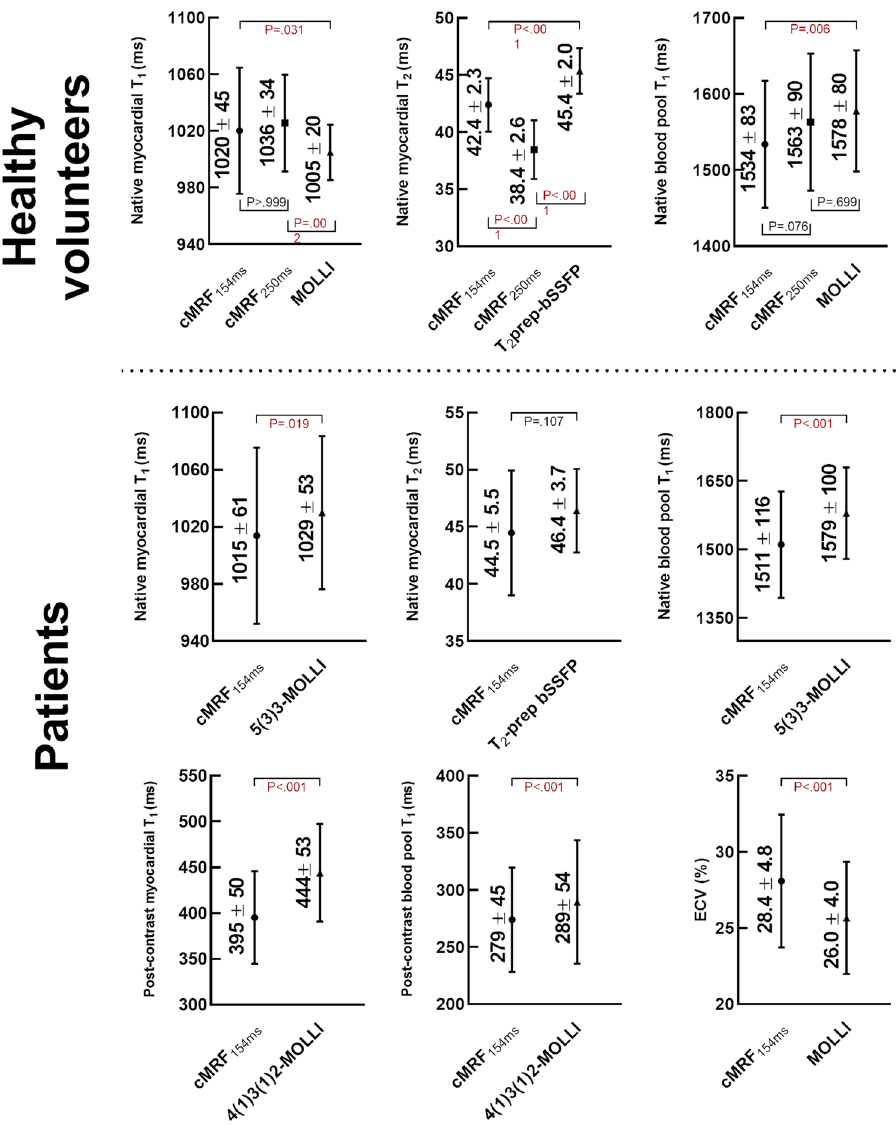
Figure 7. Myocardial relaxation times and ECV measured with short-acquisition-window cMRF and routine techniques. Similar native relaxation times were measured with all techniques in both the healthy volunteers and patients. However, the bias in the post-contrast myocardial T 1 values was higher between cMRF and MOLLI, which together with similar post-contrast blood T 1 values resulted in slightly different ECV estimations. All P values are reported on the